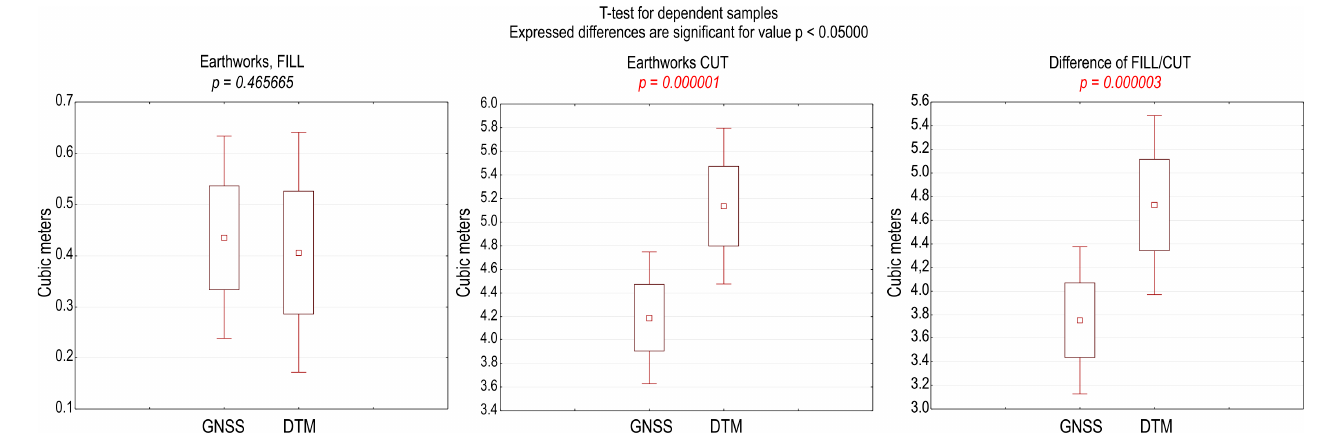
Figure 7. Results of the t -test for earthworks of Fill and Cut obtained from GNSS 3D terrain and UAV-obtained DTM.